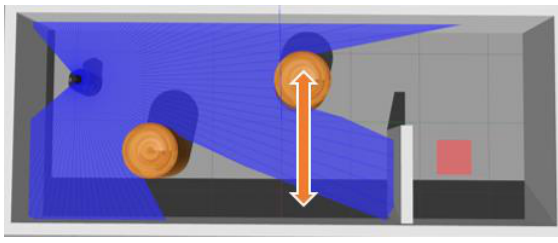
Figure 14. Map-dynamic.